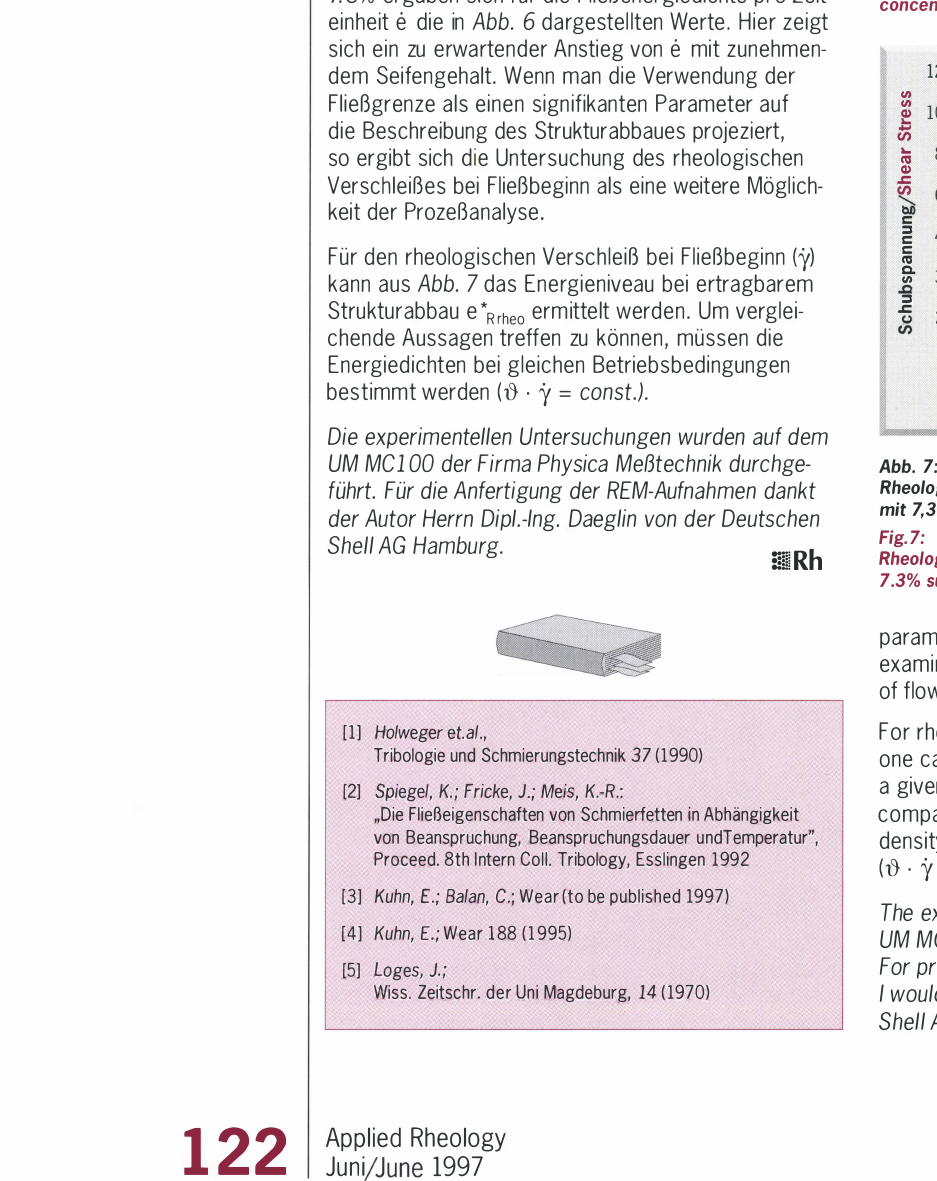
Fig. 6: Flow energy density per unit time at different surfactant concentrations and temperatures